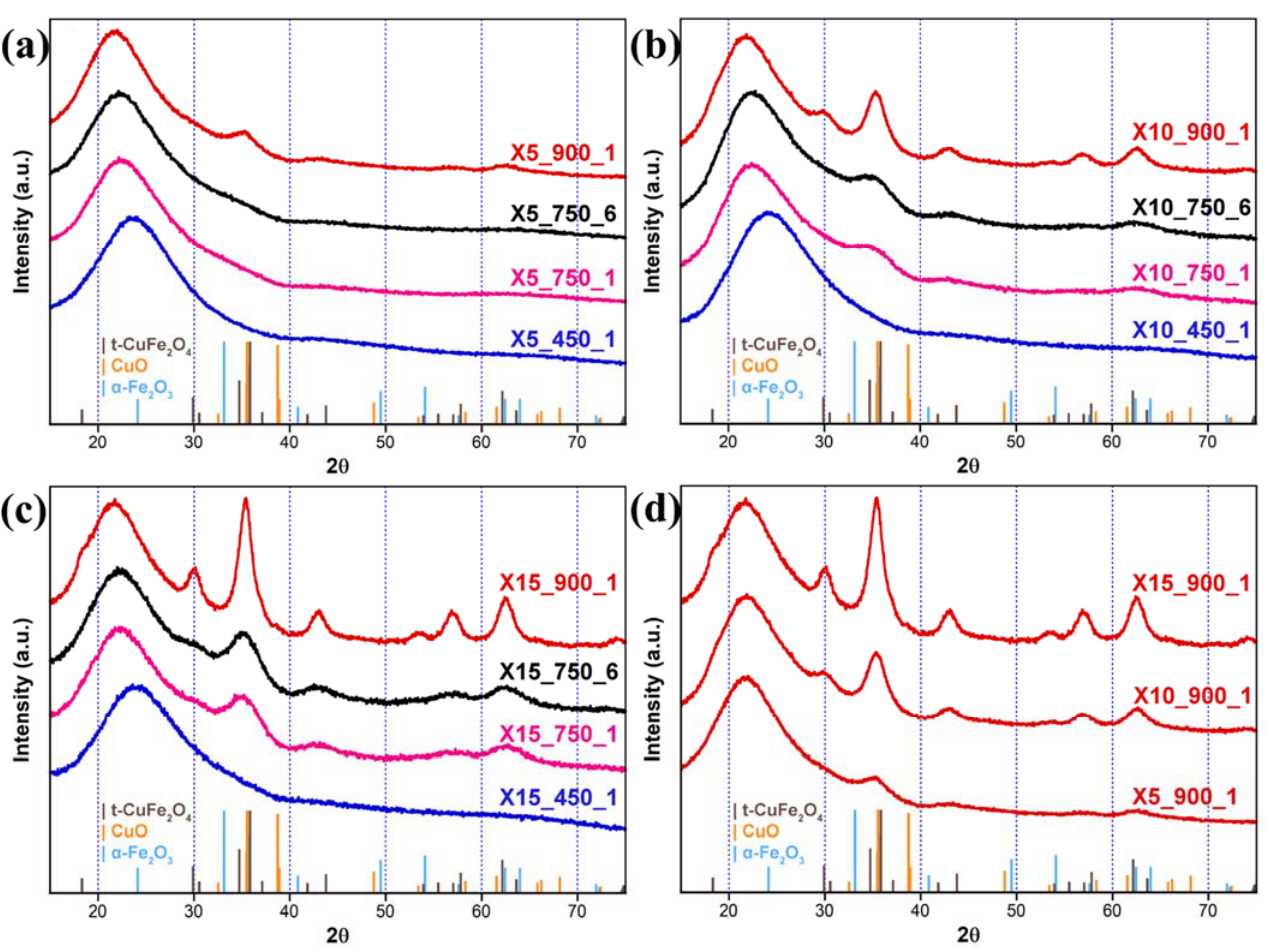
Figure 2. XRD patterns of the xerogel nanocomposites with ( a ) 5 wt%; ( b ) 10 wt%; ( c ) 15 wt% loading of the dispersed nanophase, reported as a function of the calcination temperature; ( d ) comparison of the XRD patterns of the xerogel samples after thermal treatment at 900 °C, at different CuFe 2 O 4 loadings.